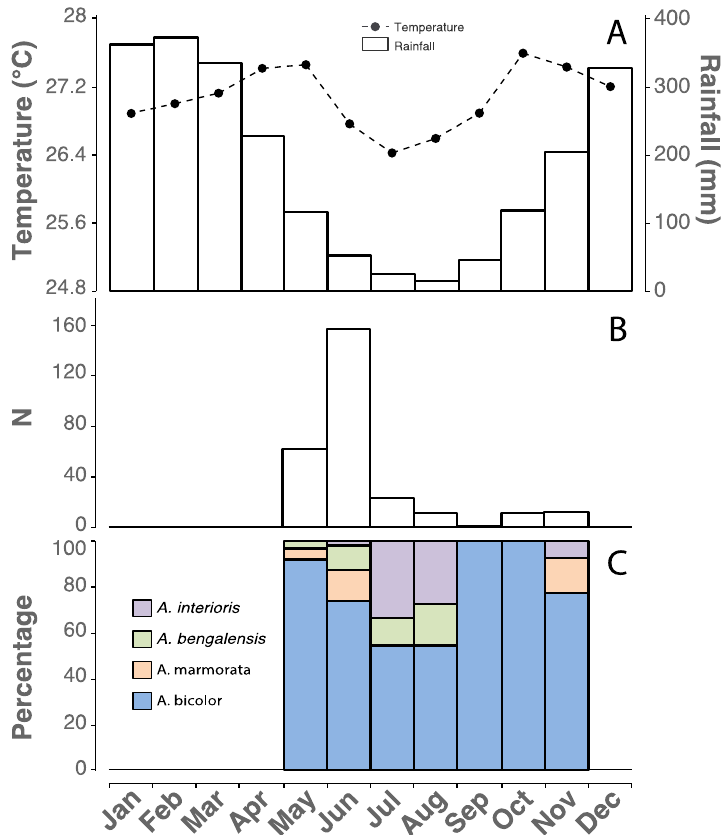
Figure 4. Abundance and species diversity of glass eels collected between March 2017 and April 2018. ( A ), monthly temperatures and rainfalls in South Sumatra and West Java between 1991 and 2016 (modified from World Bank); ( B ), number of monthly collected glass eels (N, number of individual); ( C ), monthly proportions of species among collected glass eels. All estimates of mitochondrial genetic diversity indicated that glass eels/elvers display a much lower diversity than their species gene pools (Table 2). The number of haplotypes ( h ) and the haplotypic diversity ( Hd ) were four-fold and three-fold lower, respectively, in glass eels/elvers than in yellow/silver eels. A similar trend was observed at the nucleotide level, with nucleotide diversity ( π ) and Theta ( θ w ) being two-and-a-half-fold and ten-fold lower, respectively, in glass eels/elvers than in yellow/silver eels. This result was also reflected by noticeable differences in the Tajima D test, which shifted toward a positive D value in larvae indicating a scarcity of rare alleles. However, none of the Tajima D tests performed were significant, except for the A. bengalensis / A. nebulosa species pair among yellow/silver eels with a significant negative D